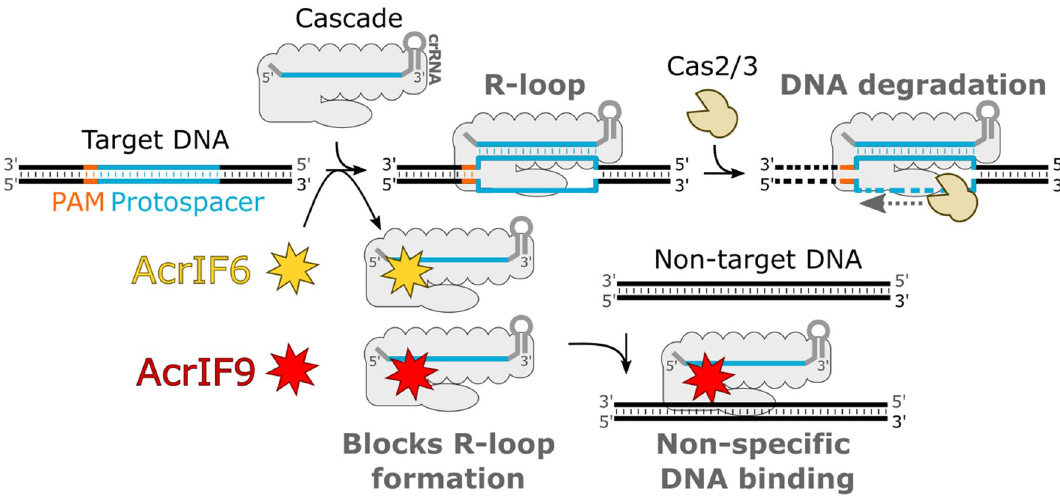
Figure 6. Inhibition mechanism of CRISPR-Cas system by AcrIF6 and AcrIF9 proteins. The Cascade complex guided by crRNA binds the target DNA forming the R-loop, which triggers Cas2/3-mediated target